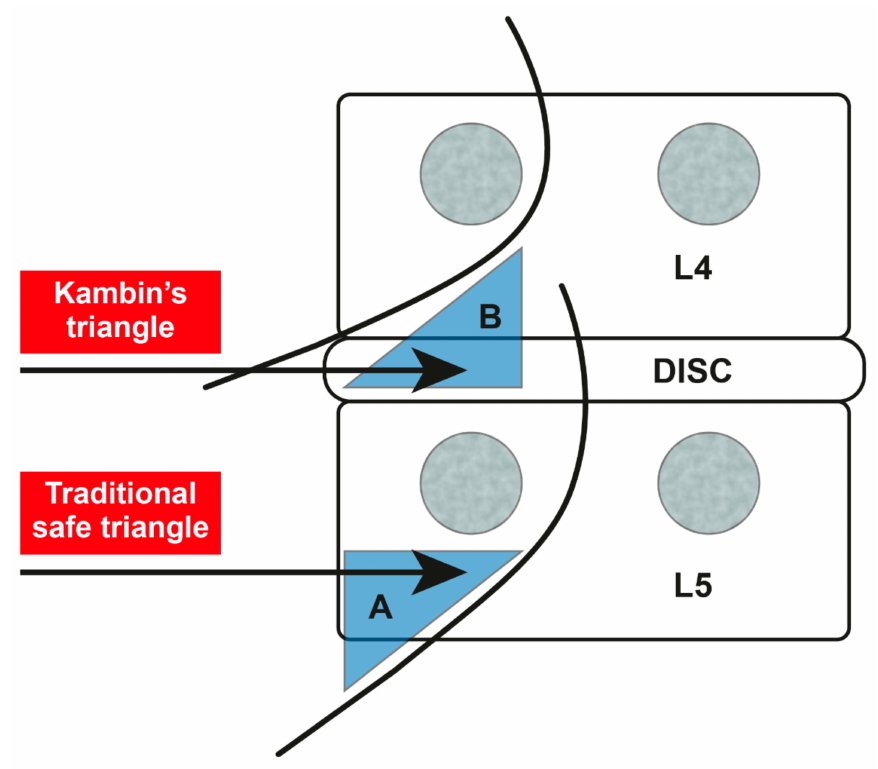
Figure 1. The safe-triangle approach ( A ) and the Kambin’s-triangle approach ( B ).